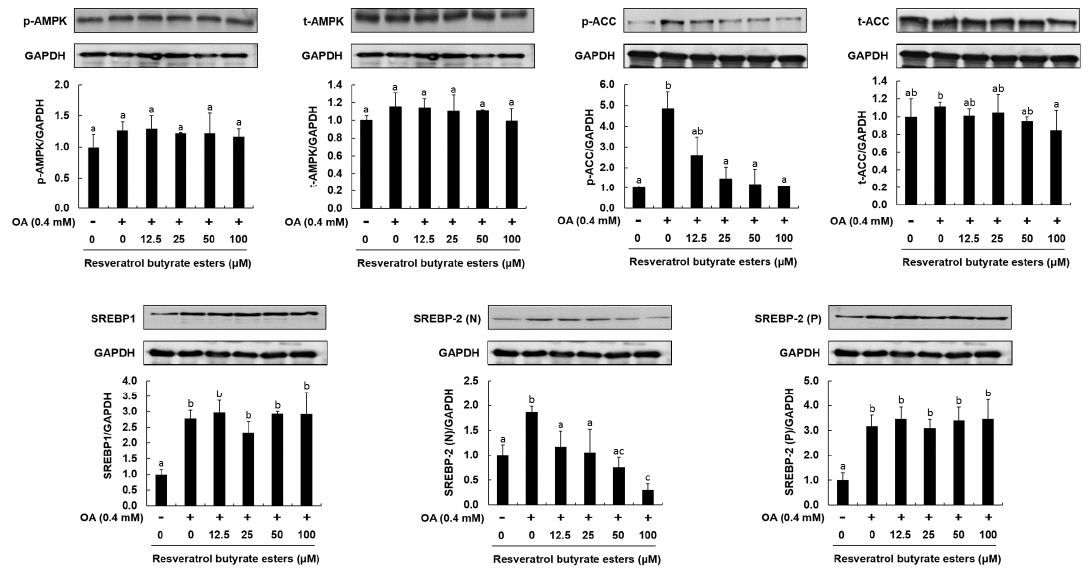
Figure 7. Effect of RBE on protein levels of p-AMPK, t-AMPK, p-ACC, t-ACC, SREBP-1, SREBP-2(N), and SREBP-2(p) in HepG2 cells. Histograms represent densitometric measurements of the specific bands of t-AMPK, p-ACC, t-ACC, SREBP-2(N), and SREBP-2(p) normalized for the expression levels of GAPDH, used as a control. Results are expressed as mean ± SD, n = 3 per group. Statistical significance was expressed as a–c p < 0.05 compared to the control.